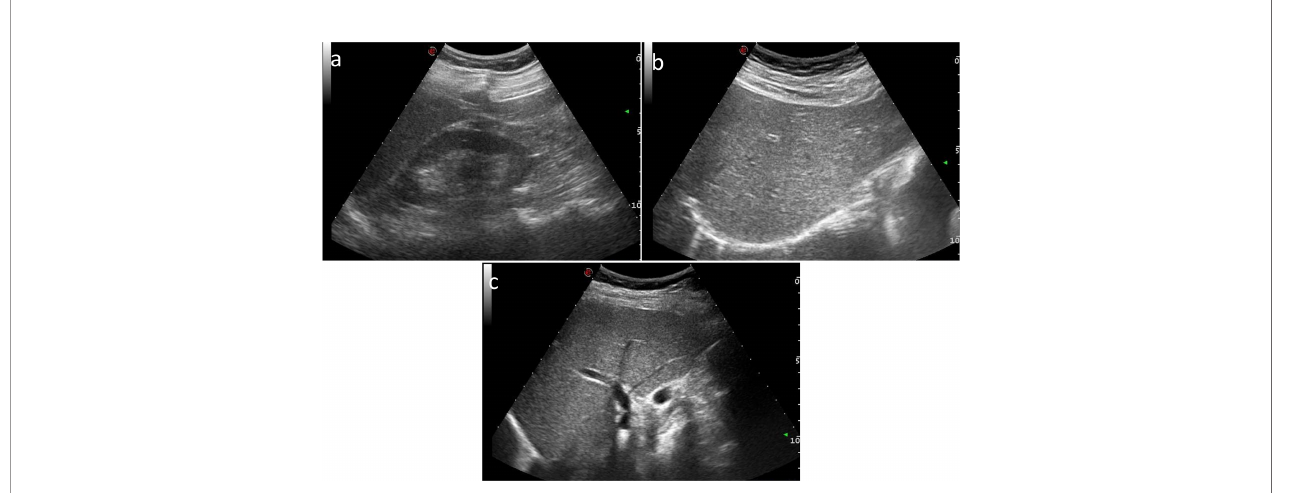
FIGURE 1 | US subcostal longitudinal scan images of (A) both liver and right kidney, (B) liver and right diaphragm, and (C) the wall of intrahepatic portal